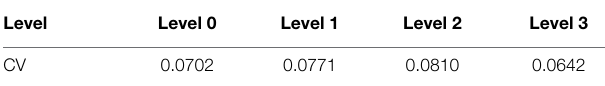
TABLE 3 | The Coefficient of variation of spectra of different disease